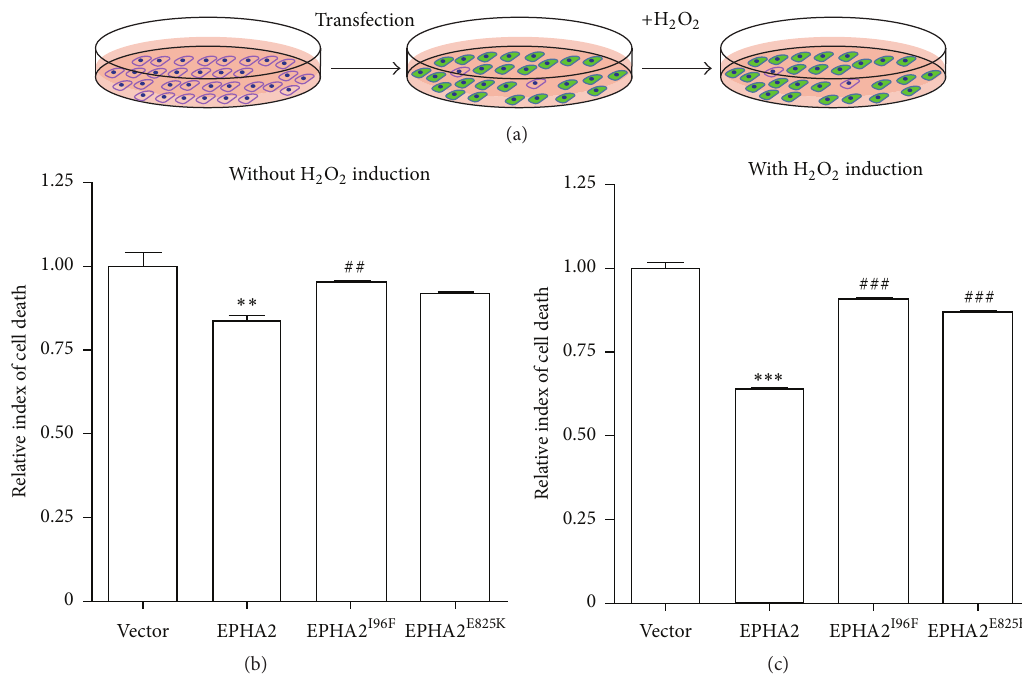
Figure 3: The functional polymorphisms abolish EPHA2-mediated cytoprotective effect. (a) The experimental paradigm. The HLECs were seeded and infected with lentivirus expressing wild-type EPHA2, EPHA 2 I 96 F , or EPHA 2 E 825 K . The infected cells were treated with 200 𝜇 M H 2 O 2 to mimic the light-induced oxidative stress in lens. (b-c) The cell viability was assayed before and after H 2 O 2 treatment following lentivirus-based gene overexpression. The quantification reveals the cytoprotective effect of wild-type EPHA2 and the loss of function in cataract-associated mutants. Data are shown as the mean ± SEM. ∗∗ 𝑝 < 0.01 , ∗∗∗ 𝑝 < 0.001 versus vector control; ## 𝑝 < 0.01 , ### 𝑝 < 0.001 versus wild-type